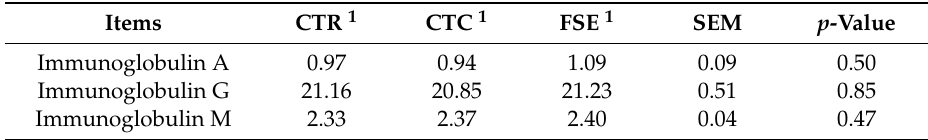
Table 6. E ff ects of Forsythia suspense extract on serum immunoglobulin levels of weaned piglets on day 28 (g / L).